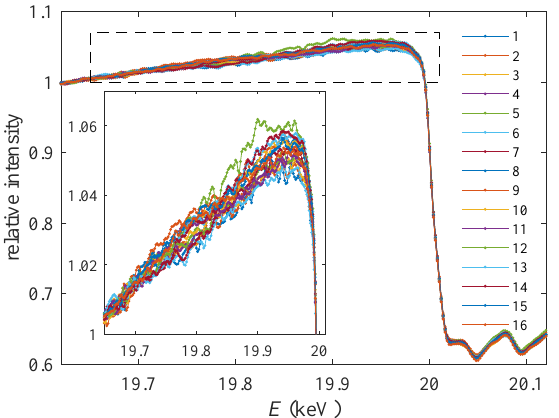
Figure 3. The AXRD spectra of individual ROIS (parameters of the curves), sample aged at 370 ◦ C/64 h. The first ROI is inside the smallest ellipse in Figure 2a, while the last ROI is between the largest and second largest ellipses. The dashed rectangular region is enlarged in the inset.